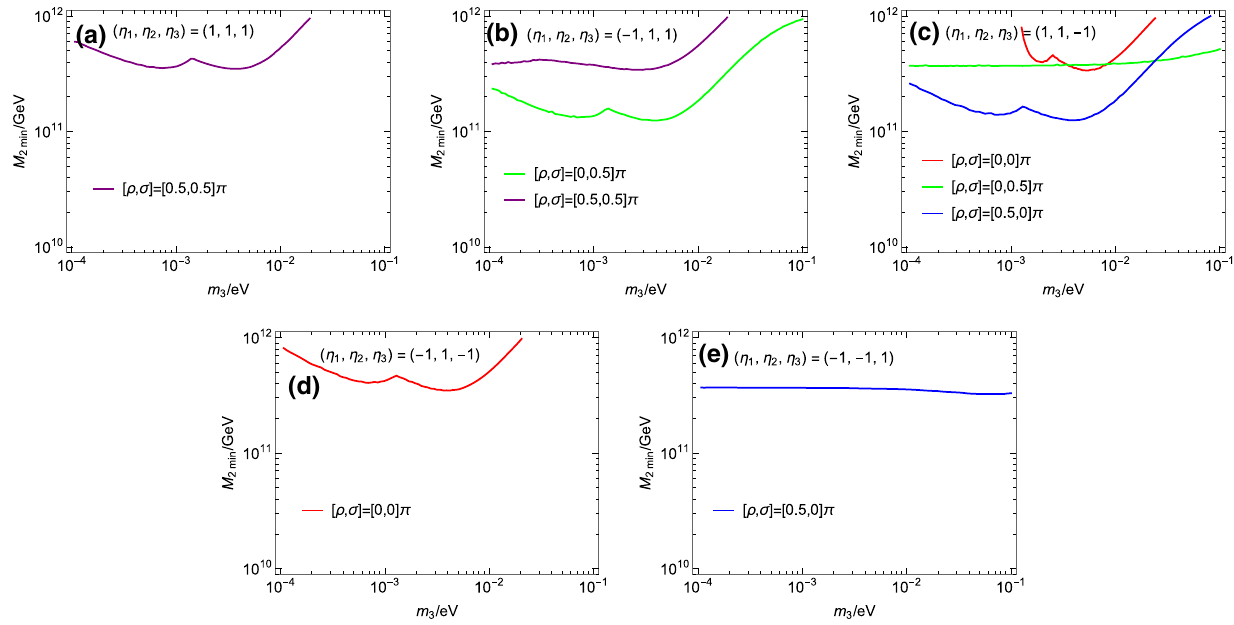
Fig. 9 Same as Fig. 8, except these results are for the IO